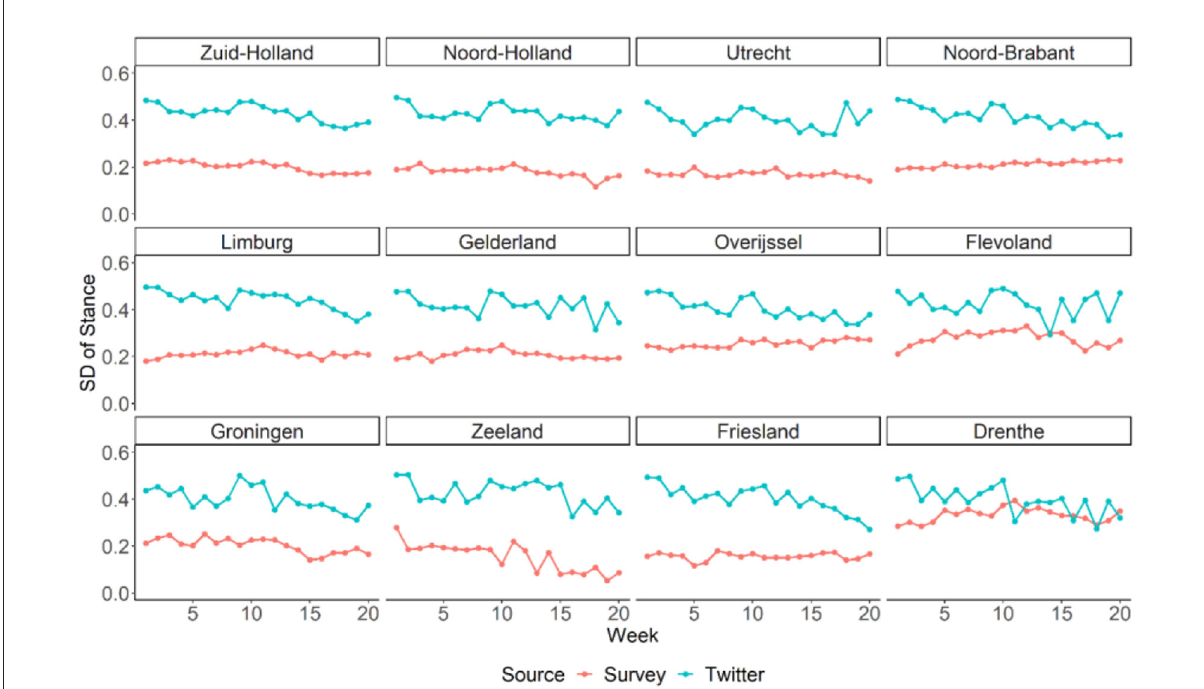
FIGURE5 Temporal variation of standard deviation ( SD ) of stance on social distancing in Dutch provinces estimated from Twitter and survey data. Provinces are ordered from left to right and top to bottom based on their population